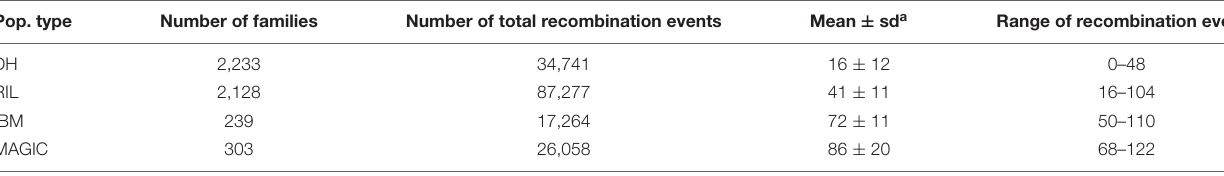
TABLE 1 | Summary of recombination events for four types of population.